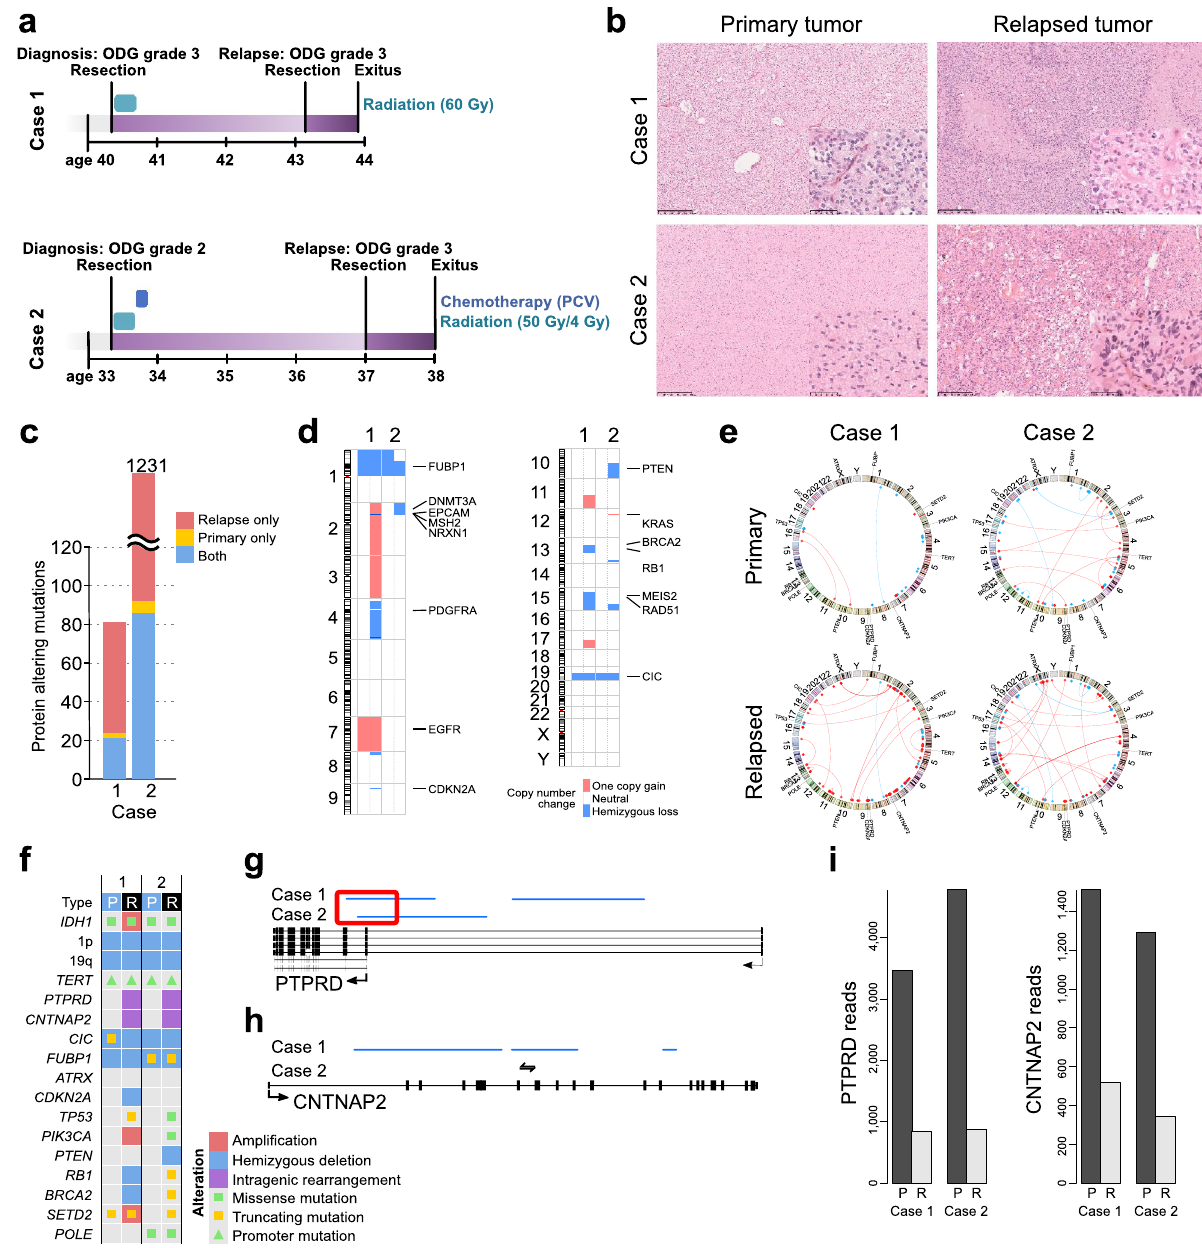
Figure 1. Clinical course and pathology of the cases with 1p19q codeletion. ( a ) Clinical course of the patients. ODG: oligodendroglioma, PCV: procarbazine, lomustine, and vincristine chemotherapy regimen ( b ) Representative H&E images from all the tumors. Scale bars indicate 250 µm (low magnification) and 50 µm (high magnification). ( c ) Genetic alterations detected in case 1 and hypermutator phenotype in case 2. The number of protein coding mutations detected in the primary tumor, relapsed tumor or both is represented in the figure. ( d ) New copy number alterations were detected in the relapsed tumors, more frequently in case 1. ( e ) Mainly focal intrachromosomal rearrangements accumulated in the relapsed tumors. Rearrangements are visualized with Circos plots. Rearrangements detected only in the primary or relapsed tumor are marked in red. ( f ) OncoPrint figure summarizing relevant alterations in the tumors. Both relapsed tumors harbored intragenic rearrangements in PTPRD and CNTNAP2 . P: primary tumor, R: relapsed tumor. ( g ) Focal deletion at the transcription start site of PTPRD in both relapsed tumors. ( h ) Intragenic rearrangements detected in CNTNAP2 after tumor relapse. Deletion was present in case 1 and inversion in case 2. ( i ) The expression of both PTPRD and CNTNAP2 was strongly decreased after relapse. Bar plot showing the number of reads in normalized samples. P: primary, R: